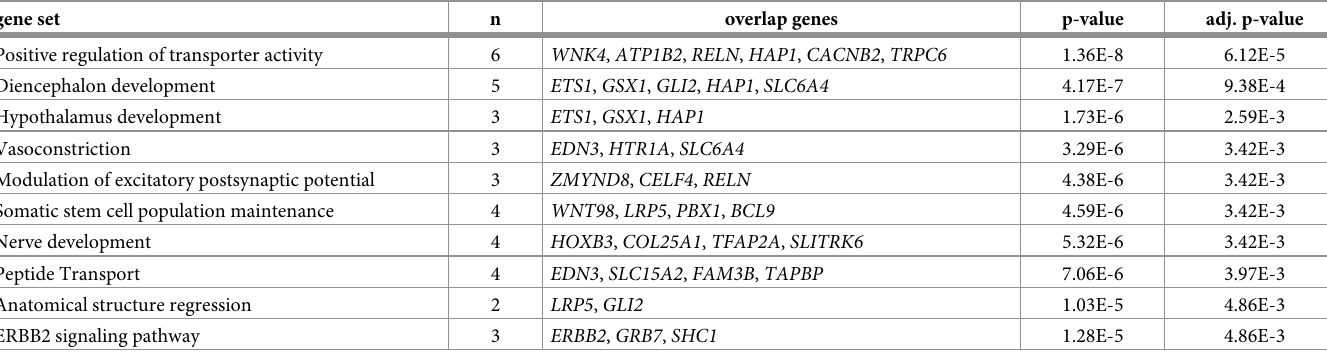
Table 3. Top gene sets enriched for hypermethylated genes in